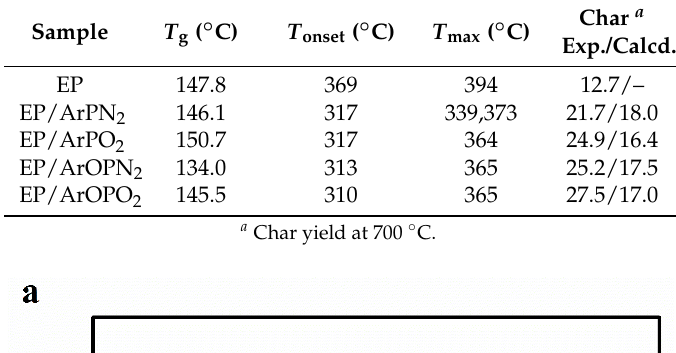
Table 2. Thermal properties of epoxy (EP) and EP/polysulfone composites.